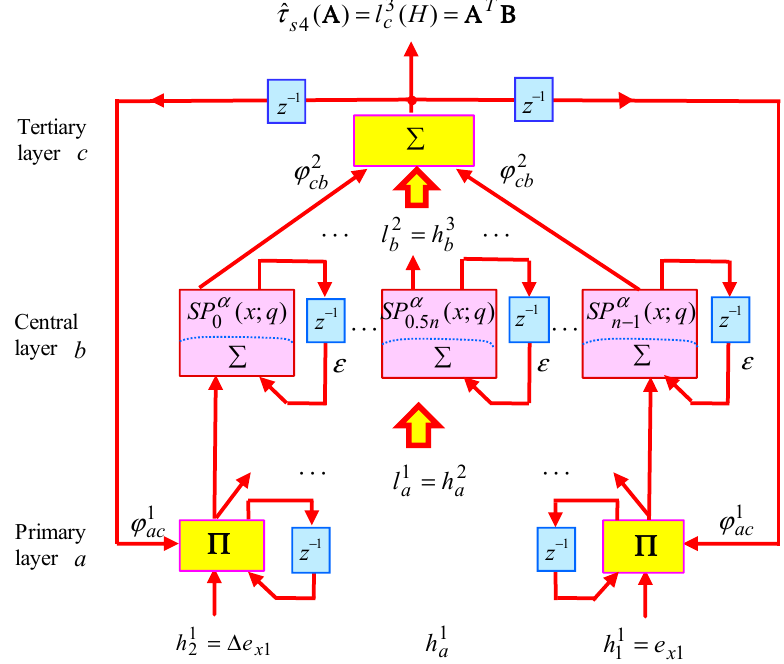
Figure 4. Constitution of the rectified reiterative sieved-Pollaczek polynomials neural network. The minimum reorganized error